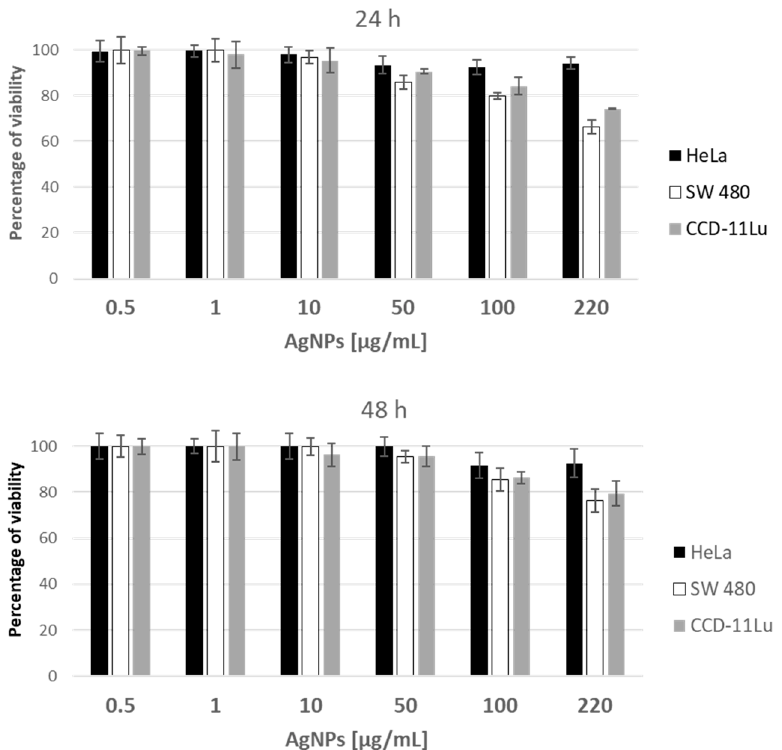
Figure 10. Viability (%) of human cell lines exposed to the increasing concentrations of AgNPs, assessed with the use of (3-[4,5-dimethylthiazol-2-yl])-2,5 diphenyl tetrazolium bromide (MTT) assay after 24 and 48 h of incubation.